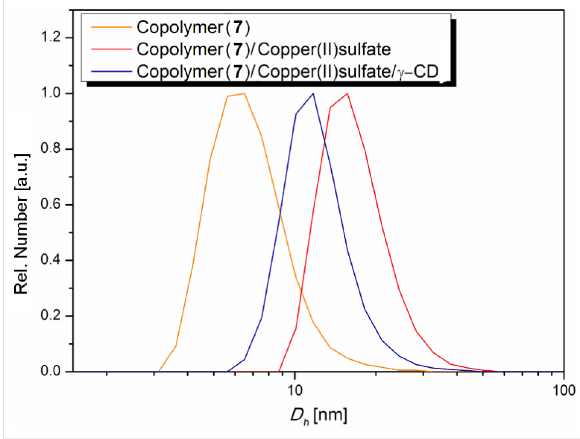
Figure 3: Number average particle size distribution of 7 obtained by DLS